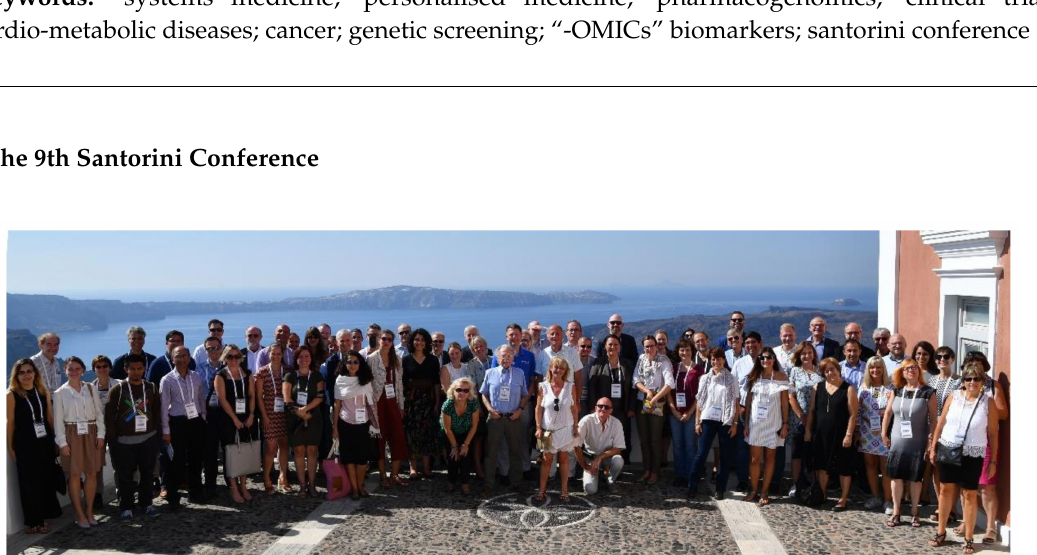
Figure 1. Participants of The 9th Santorini conference in Petros M. Nomikos Conference Centre. (Photo by George